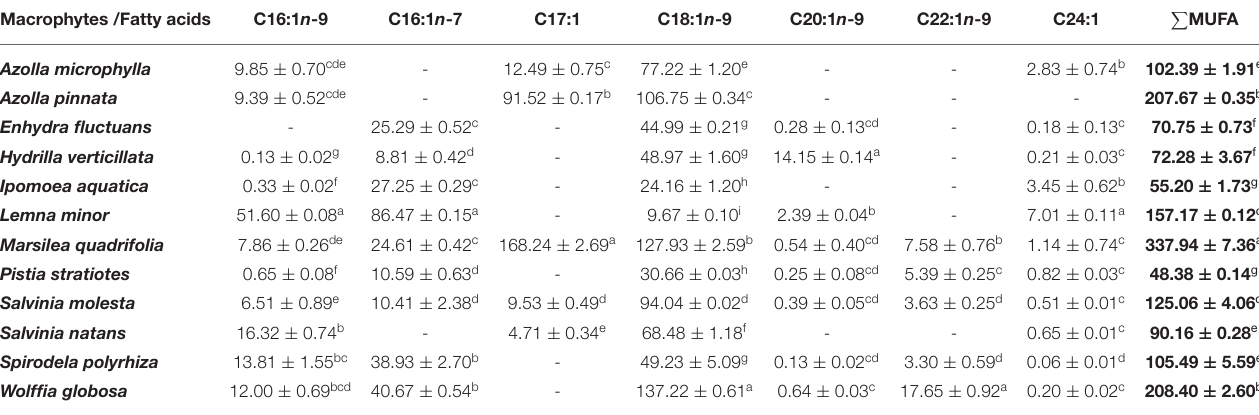
Values having the means (n = 3) in each row with different superscript are significantly (p < 0.05) different.